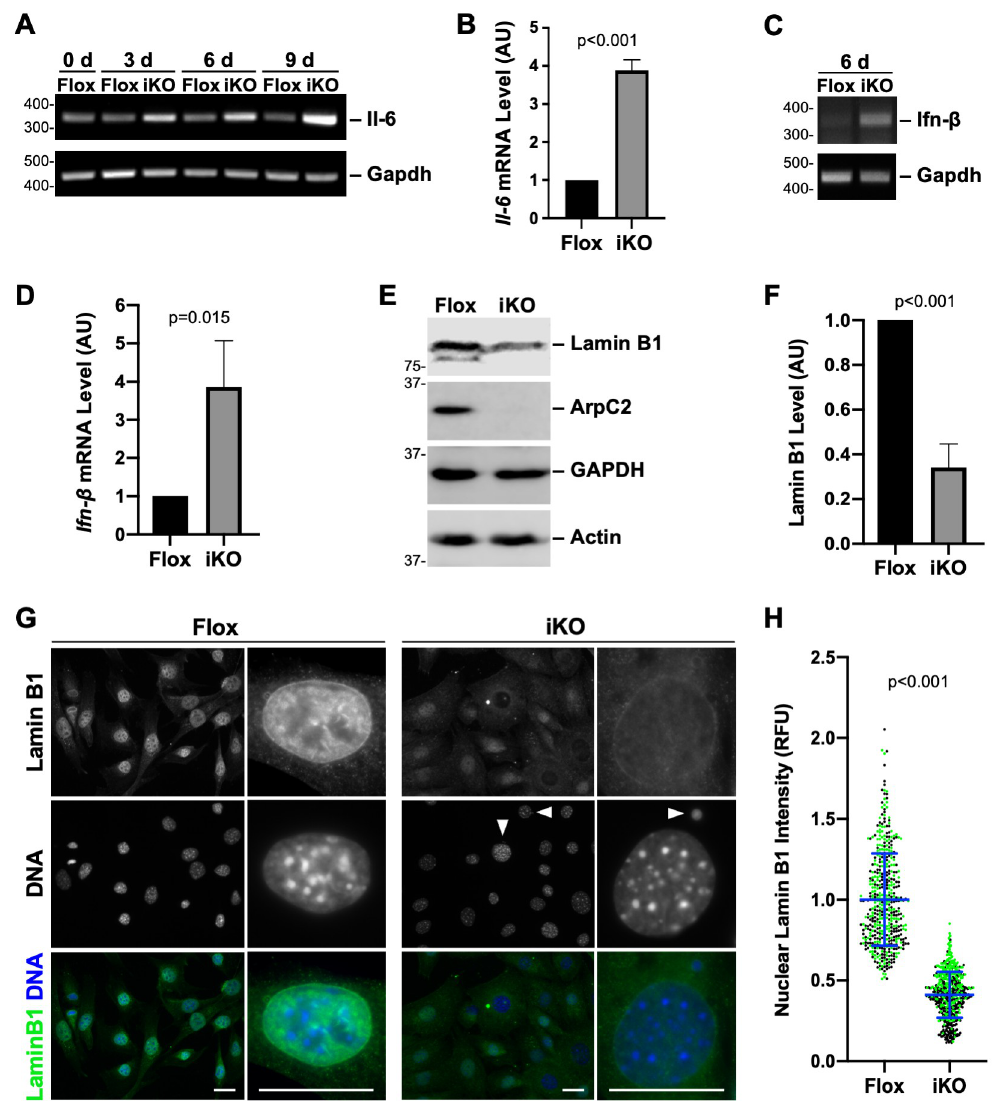
Fig 2. Loss of the Arp2/3 complex results in elevated Il-6 and Ifn- β transcript levels and decreased nuclear Lamin B1 expression. (A) Mouse fibroblasts were treated with DMSO (Flox) or 4-OHT (iKO) for 0-6d and collected at 0, 3, 6, and 9d. RNA was isolated and RT-PCR performed using primers for Il-6 and Gapdh . PCR products were visualized on ethidium bromide-stained agarose gels. (B) RT-qPCR was performed using primers for Il-6 and Gapdh at 9d. Il-6 product levels were normalized to Gapdh . Each bar represents the mean transcript abundance ± SD from n = 3 experiments. AU = Arbitrary Units. (C) RT-PCR was performed on Flox and iKO samples using primers for Ifn- β and Gapdh at 6d. (D) Agarose gel band intensities for Ifn- β were normalized to Gapdh intensities. Each bar represents the mean Ifn- β intensity ± SD from n = 3 experiments. (E) Flox and iKO cells were collected at 10d and immunoblotted with antibodies to Lamin B1, ArpC2, GAPDH, and actin. (F) Lamin B1 band intensities were normalized to GAPDH and actin band intensities. Each bar represents the mean intensity ± SD from n = 3 experiments. (G) Flox and iKO cells were fixed at 9d and stained with a Lamin B1 antibody (green) and DAPI (DNA; blue). Arrowheads point to micronuclei. Magnifications illustrate strong nucleoplasmic Lamin B1 localization for Flox cells. Scale bars, 25 μ m. (H) Nuclear Lamin B1 levels were quantified by outlining the DAPI-stained nucleus of each cell in ImageJ and measuring the mean Lamin B1 pixel intensity. Each dot represents an individual cell and the blue line depicts the average Lamin B1 pixel intensity ± SD from analyses of n = 492– 556 cells pooled from 2 experiments (denoted in black or green). RFU = Relative Fluorescence Units.